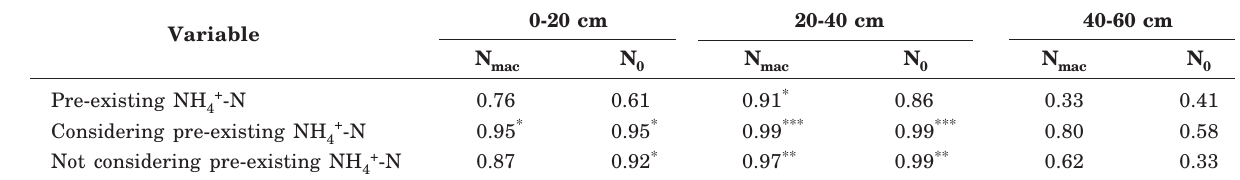
Table 5. Correlation coefficients (R) among the following indexes: the amount of pre-existing NH 4+ -N in the soil and the amount obtained after anaerobic incubation (considering or not considering the pre-existing NH 4+ -N), accumulated mineralized N under aerobic incubation (N mac ) and potentially mineralizable